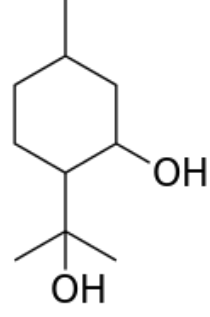
Figure 21. p -Menthane-3,8-diol.